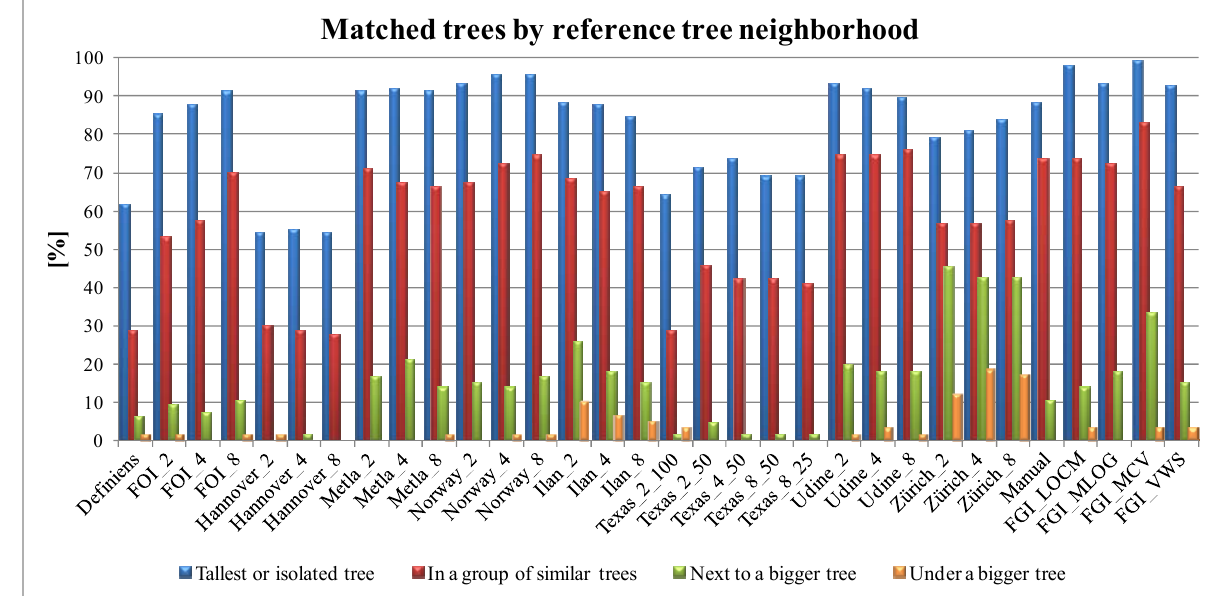
Figure 6. The best percentage of correctly matched trees was achieved using the FGI_MCV-model,